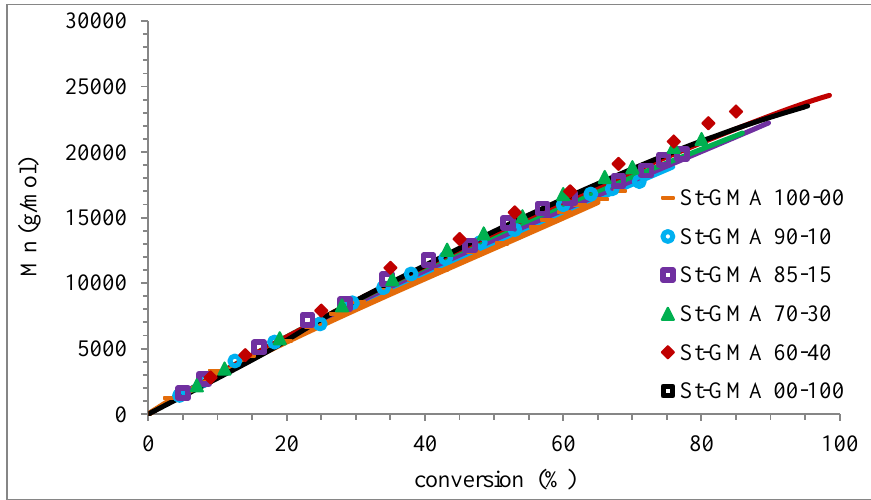
Figure 10. Profiles of M n versus conversion for the different St-GMA samples. Symbols and solid lines correspond to experimental and calculated profiles, respectively.